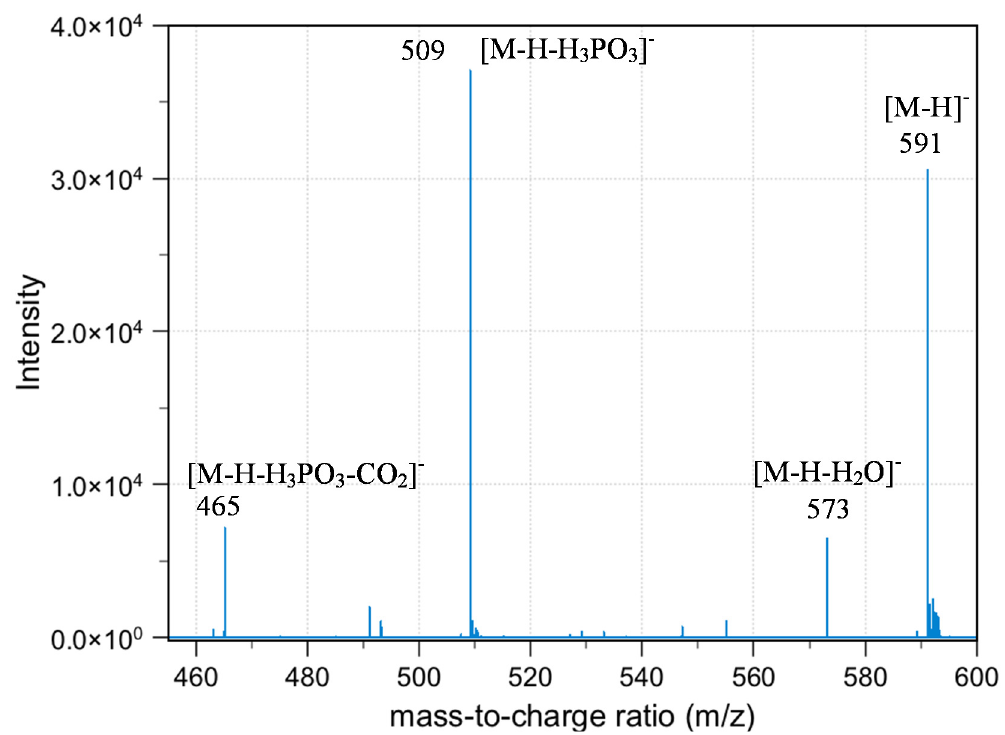
Figure 10. ESI ‐ MS n mass spectrum of NODPAM producing the 591 [M − H] − precursor ion and 509 [M − H ‐ H 3 PO 3 ] − base peak.